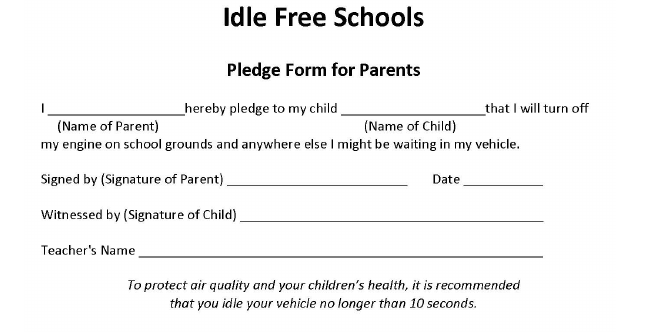
Vehicles 2022 , 4 , FOR PEER REVIEW Figure A5. Idle-free schools flyer. Figure A5. Idle-free schools flyer.